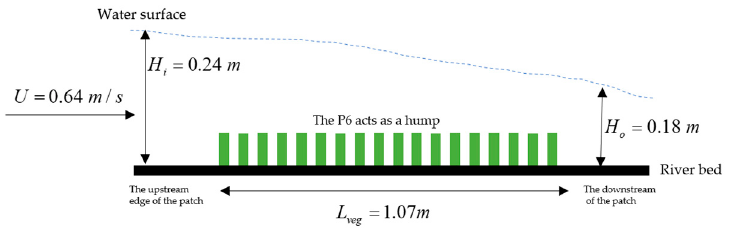
Figure 5. The variation in the water surface profile over